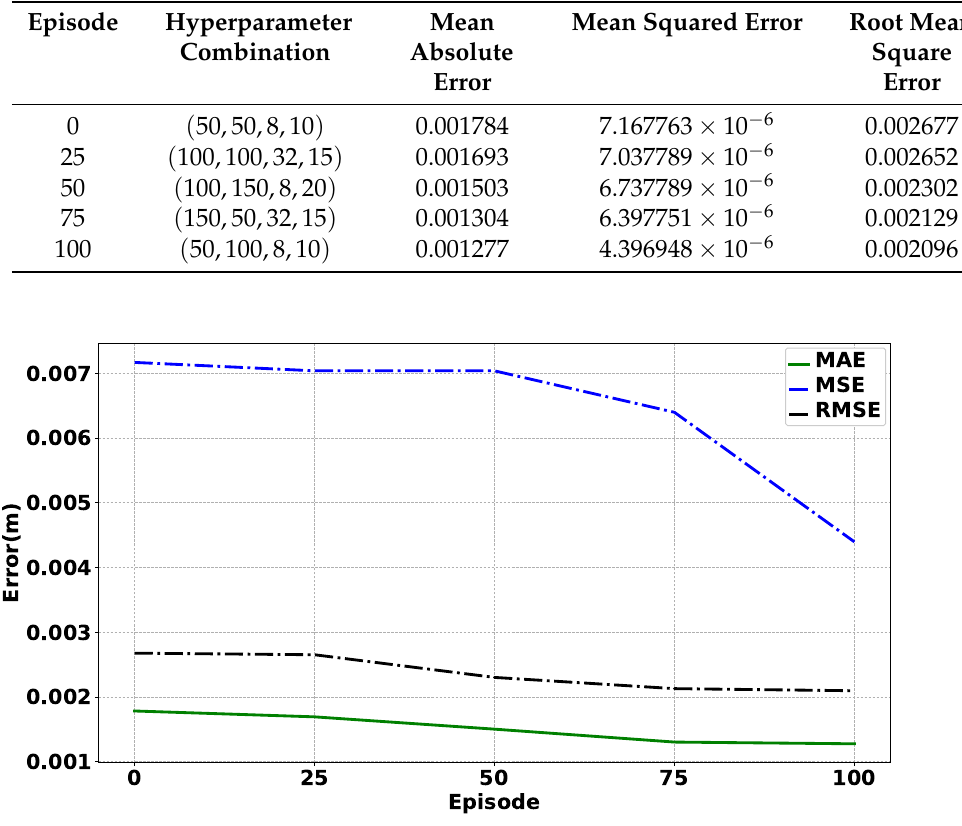
Figure 8. Loss results at different stages. Table 4. Results of LSTM neural network hyperparameter optimization.